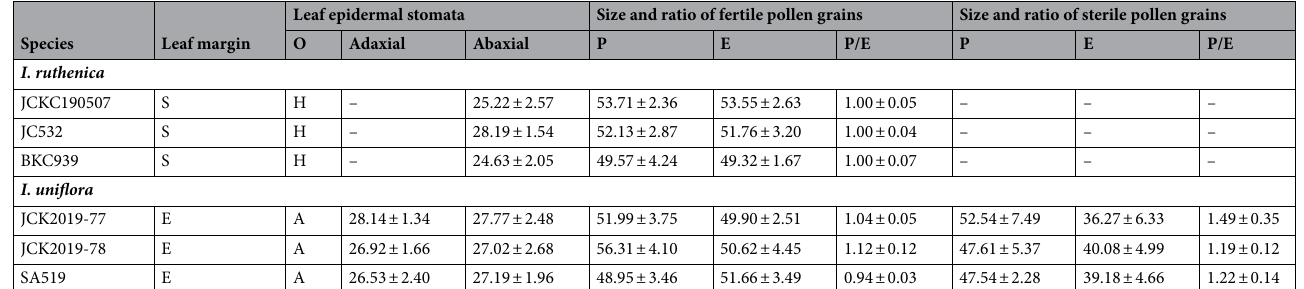
Table 2. Overview of leaf and pollen morphological characters of Iris ruthenica and I. uniflora examined using light microscope. Leaf margin: S, serrate; E, entire. Leaf epidermal stomata occurrence (O): A, amphistomatic; H, hypostomatic or absent or extremely rare. Size and ratio of pollen grains: P, polar diameter; E, equatorial diameter; P/E, polar diameter/equatorial diameter. All size measurements are in µm (mean ± standard